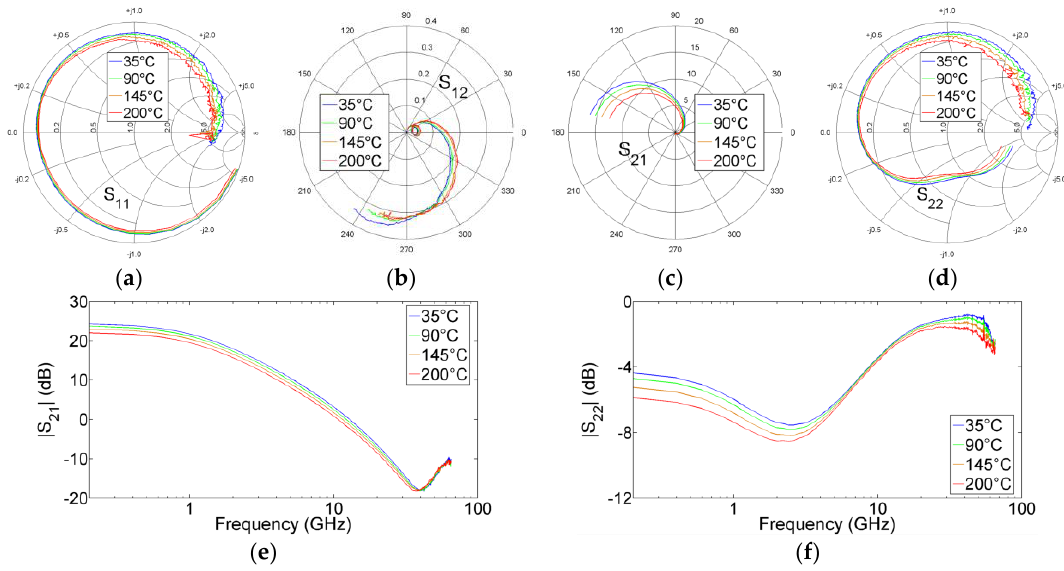
Figure 2. Measured ( a ) S 11 , ( b ) S 12 , ( c ) S 21 , ( d ) S 22 , ( e ) magnitude of S 21 , and ( f ) magnitude of S 22 from 0.2 to 65 GHz for a GaN HEMT at V DS = 30 V and V GS = − 3.5 V under four ambient temperatures: 35 °C, 90 °C, 145 °C, and 200 °C.